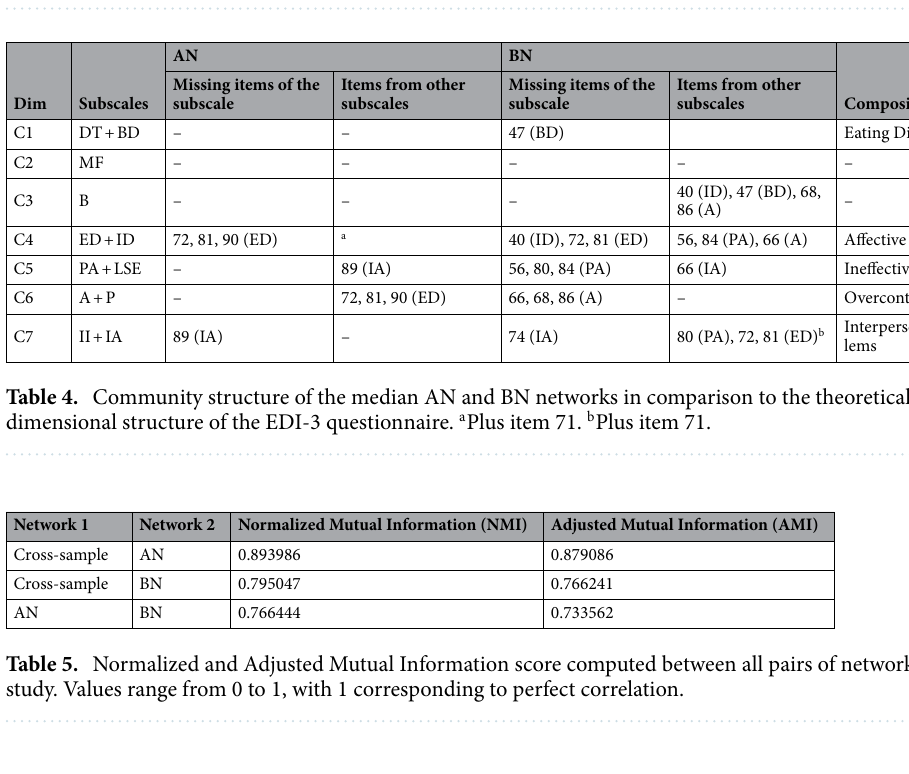
Figure 3. Community structure of the median graphs corresponding to the AN and BN subpopulations. Note that the node composition of the AN and BN networks is slightly different because of a few diverging results of the redundancy analysis. Items assigned to a community different from the corresponding subscales are those hooped with a red circle.